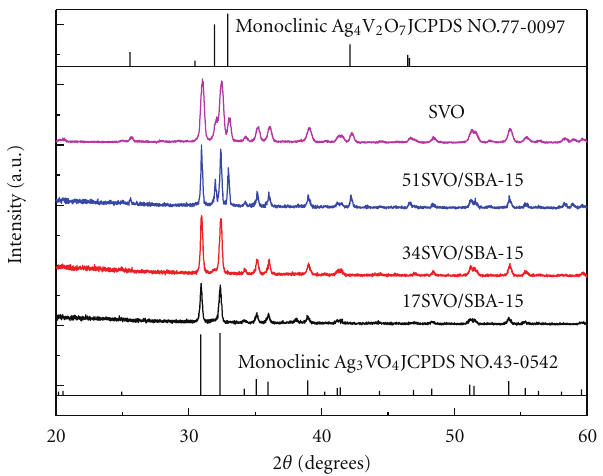
Figure 2: N 2 adsorption-desorption isotherms of SBA-15 and SVO/ SBA-15